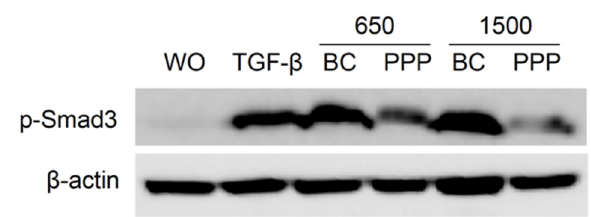
Figure 8. The BC fraction of PRF 650 g and 1500 g provoked phosphorylation of Smad3. Gingival fibroblasts were exposed to 30% of the BC and PPP fractions of PRF lysates prepared at 650 g and 1500 g for 16 h. Western blot showed a strong increase of the basal Smad3 phosphorylation signal by both BC fractions compared to the weak signal generated by PPP fractions.